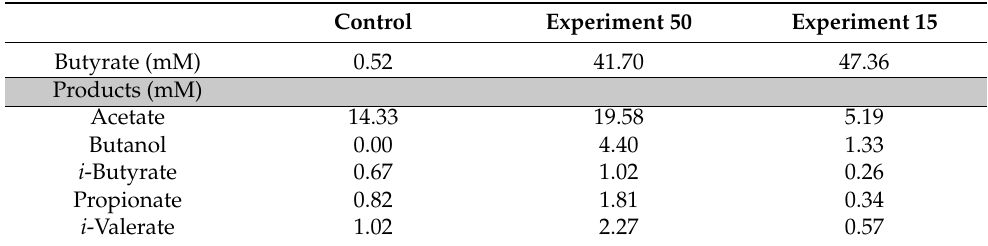
Table 2. Measured substrate concentration (butyrate) and maximum product concentrations after 10 days of fermentation in 1 L Schott bottles.